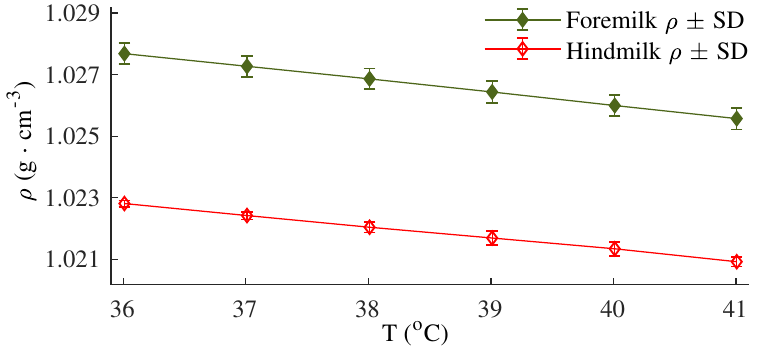
Figure 7. Density Test #2 for samples from Participant #8 for intra-feed (foremilk/hindmilk) and inter-breast (shown with SD caps) variations tested fresh. While higher fat content lowers density, inter-breast differences are minimal, particularly for hindmilk.